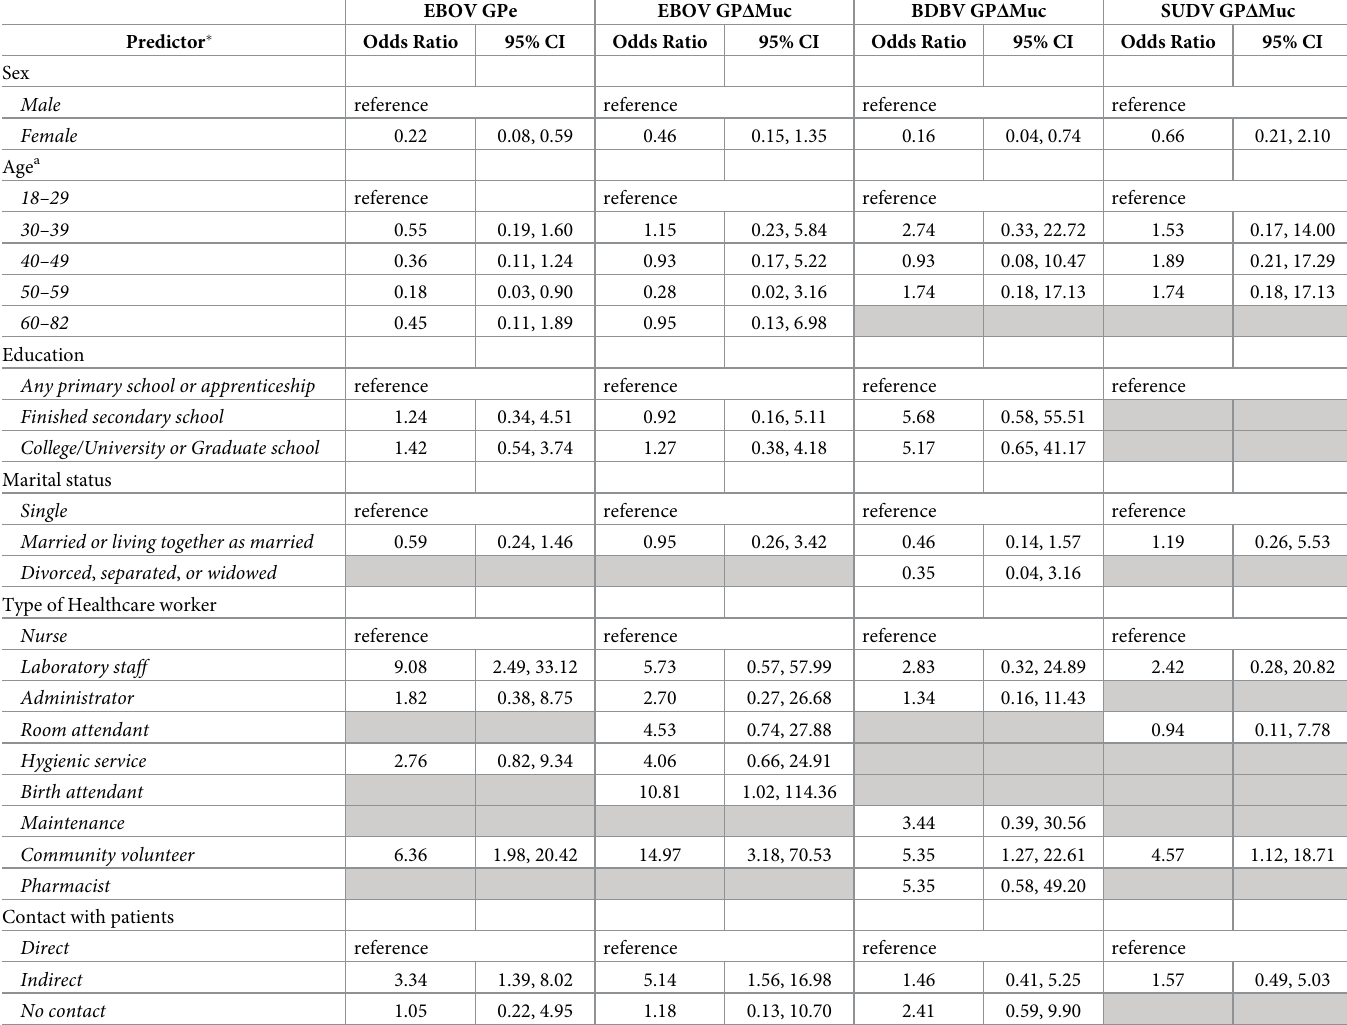
Table 4. Predictors of Ebola virus-specific and ebolavirus cross-reactive antibody levels of 539 participants from Mbandaka and the surrounding areas in the Demo- cratic Republic of the Congo, August